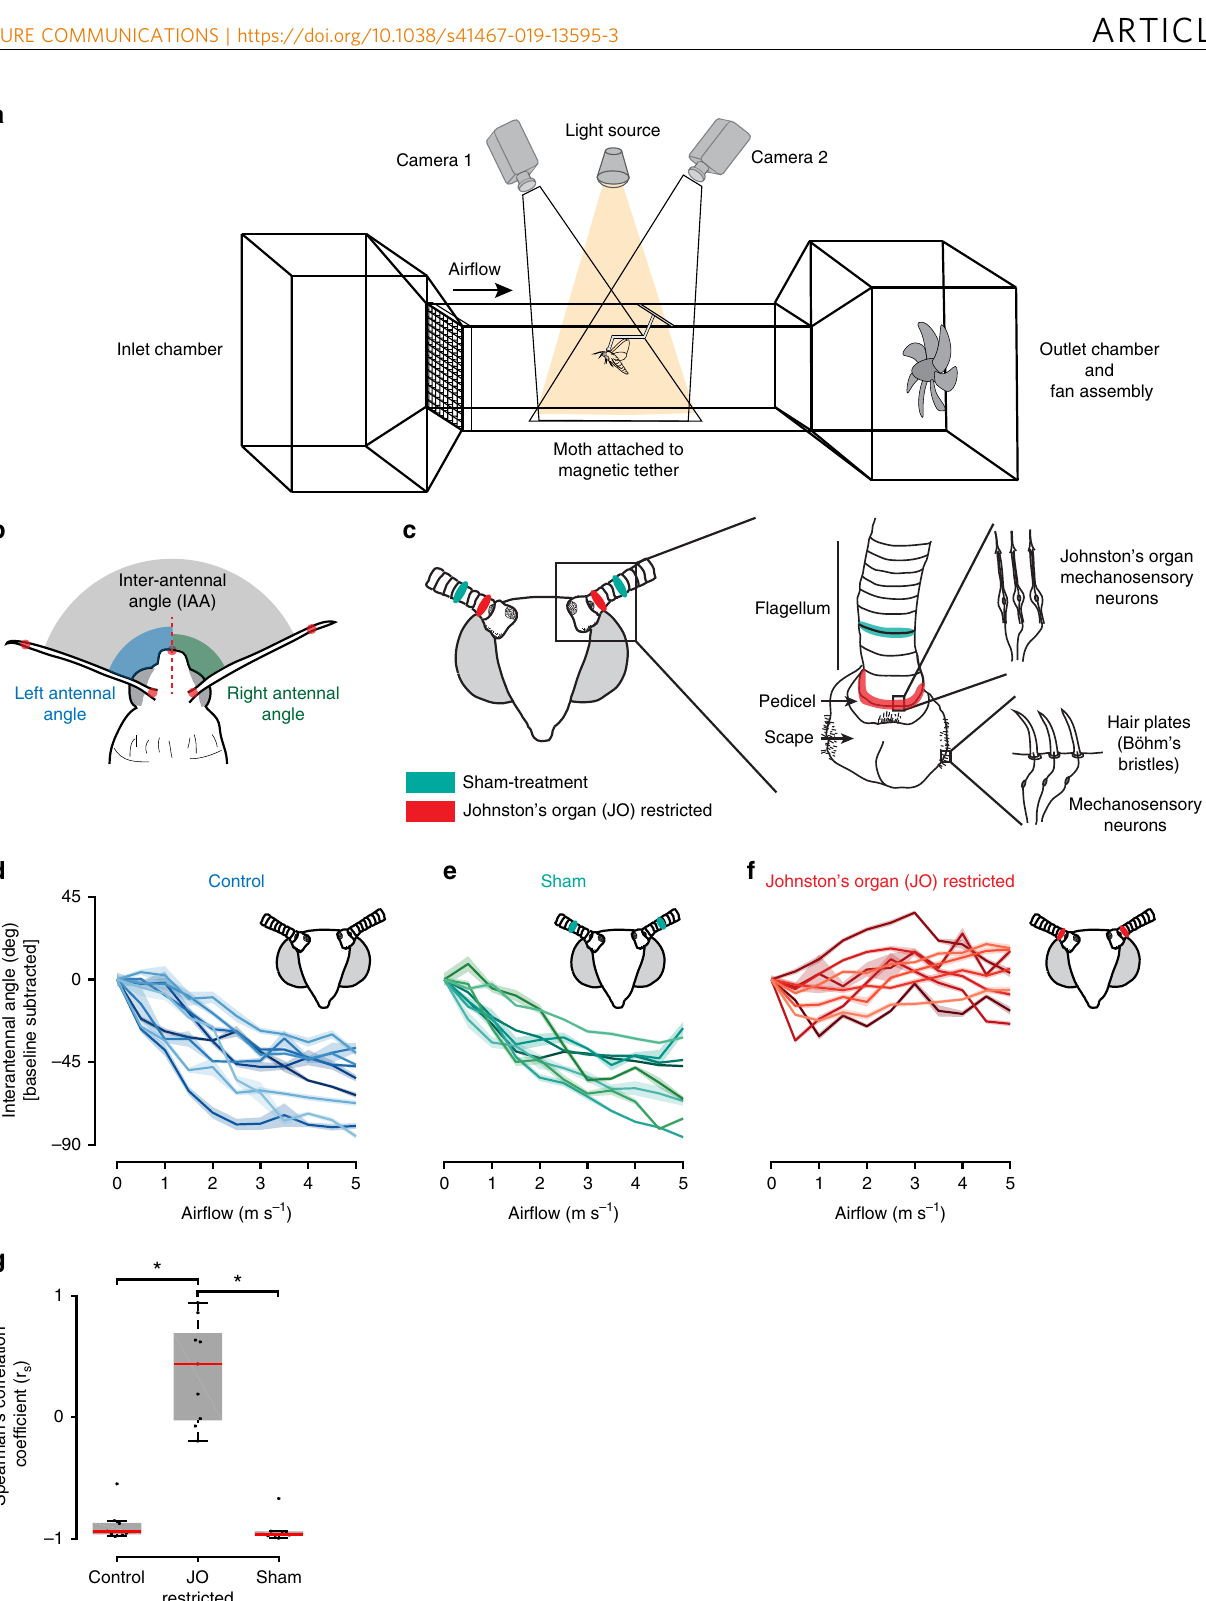
fl ight (Fig. 1f, Supplementary Fig. 2C – F, Supplementary Movie 3), although the antennae were still mobile (Supplementary Movie